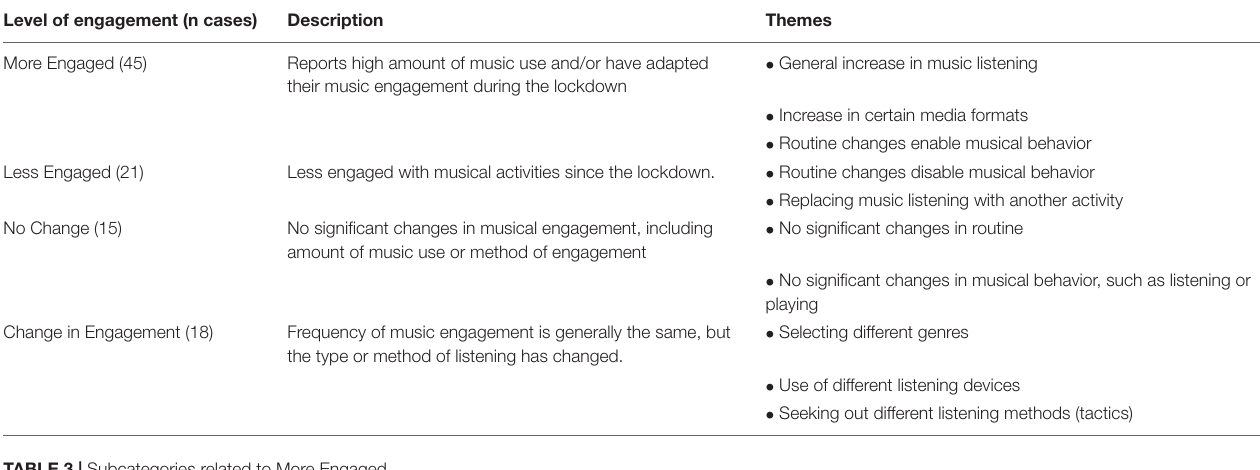
TABLE 2 | Major themes which emerged from free text answers.